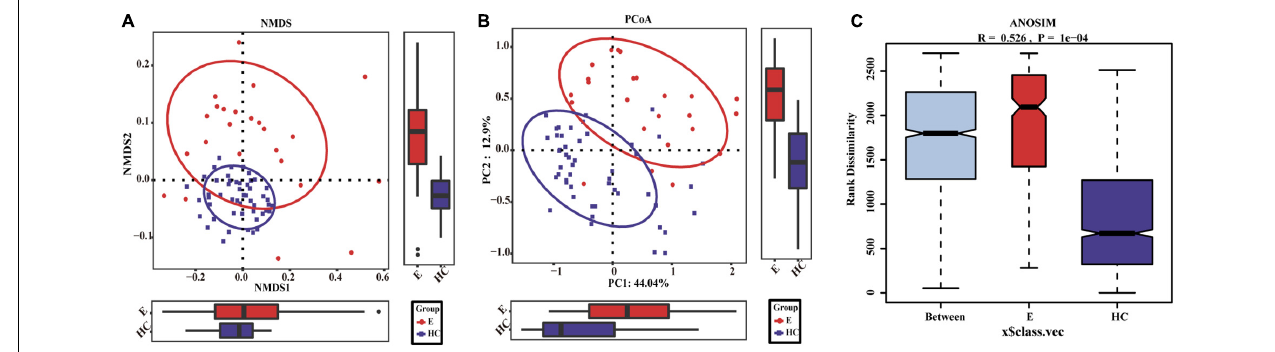
FIGURE 3 | Differences in fecal microbiomes between Eps ( n = 24) and HCs ( n = 50). (A) β -Diversity was calculated by NMDS analysis of unweighted UniFrac distances. Samples from the Eps and HC (blue) groups were distinctly separated along the NMDS2 axis, which means that individuals with epilepsy were substantially different from healthy individuals. (B) PCoA of unweighted UniFrac PC1-2 showed that the samples from the Eps and HC (blue) groups were distinctly separated along the PC2 axis, which means that the overall fecal microbiota compositions were markedly different between Eps and HCs. (C) ANOSIM showed that there were significant differences between the two groups ( R = 0.526, P = 1e-04). Each symbol represents a sample (red, Eps; blue, HCs). The variance explained by the PCs is indicated by parentheses on the axes.